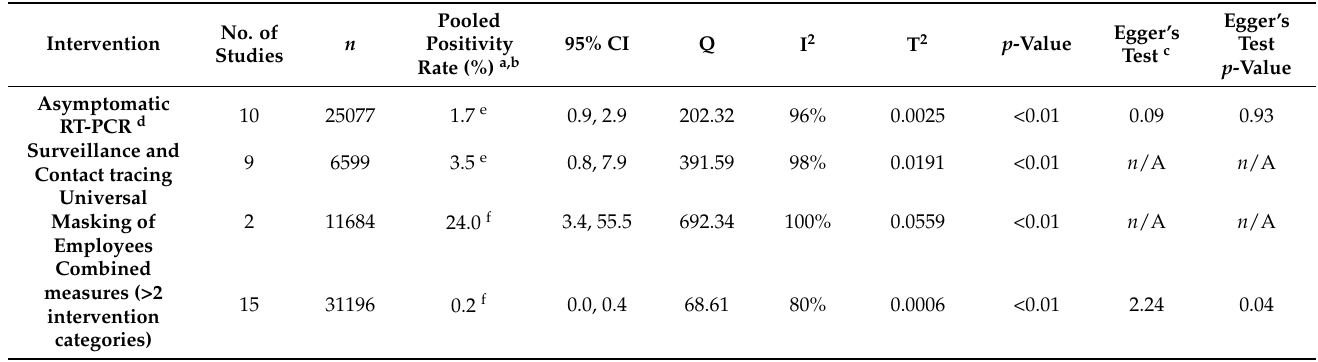
Table 7. Meta-analysis of COVID-19 positivity rates according to the IPC measures